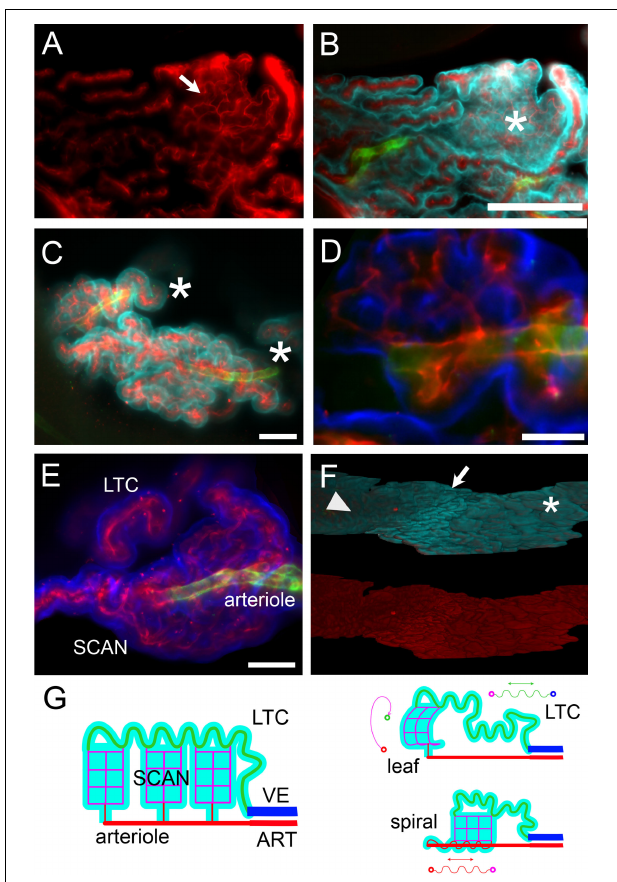
FIGURE 9 | Microvascular network and frond structure. (A) SCAN within a single villus in the loose part of LHS of a female rat. The anastomotic pattern of the small capillary network (arrow) is evident. Collagen IV labeling. (B) Same section as in (A) , additionally labeled for CP epithelium (Notch2, cyan) and arterioles (SMA, green). One flat villus is en face in this section (asterisk), and its whole lateral surface is visible. The distribution of large capillaries at the periphery and small capillary (SCAN) in the center is evident. This SCAN attaches to its parent arteriole following a loose spiral course (see Supplementary Video 6 ). Scale bar: 200 µ m. (C) Terminal region of corkscrew-like villi from the loose part of CSS. Arterioles are seen in the middle, associated with spiraling capillaries. Asterisks mark the direction of the parent artery. Green, SMA; red, ColIV; cyan, Notch-2. Scale bar: 100 µ m. (D) Single optical slice with a magnification of a portion of the top villus in (C) , showing that the arteriole is associated with capillaries running within the same villus. Scale bar: 50 µ m. Green, SMA; red, ColIV; blue, Notch-2. (E) Z-stack maximal projection from 50 optical sections (3 µ m steps) displaying a SCAN associated with its arteriole and LTC. Scale bar: 100 µ m. (F) Three-dimensional reconstruction of the LHS surface of a female rat facing the DCN. Top: Notch-2 (cyan) + ColIV (red) + SMA (green) labeling. Bottom: colIV labeling (red). Notice the passage from leaflike villi (asterisk) to digitiform villi (arrow) to flat surface (arrowhead) passing from the caudal to the rostral part of LHS. Scale bar: 500 µ m. (G) Schema of hCP vascular network. Arteries (ART) divide into arterioles, which give rise to SCANs (magenta) through divergent connections. At their other end, SCANs contact LTCs (green) which course back to reach veins (VE). Since LTCs are very long, a single capillary may fill an entire frond, and SCANs are attached via multiple outlets to a single LTC. Probably due to growth with spatial constraints, both SCANs and LTCs may display a tortuous pathway; differential growth of SCANs and LTCs (and possibly pre-SCAN vessels) may produce all microvascular patterns